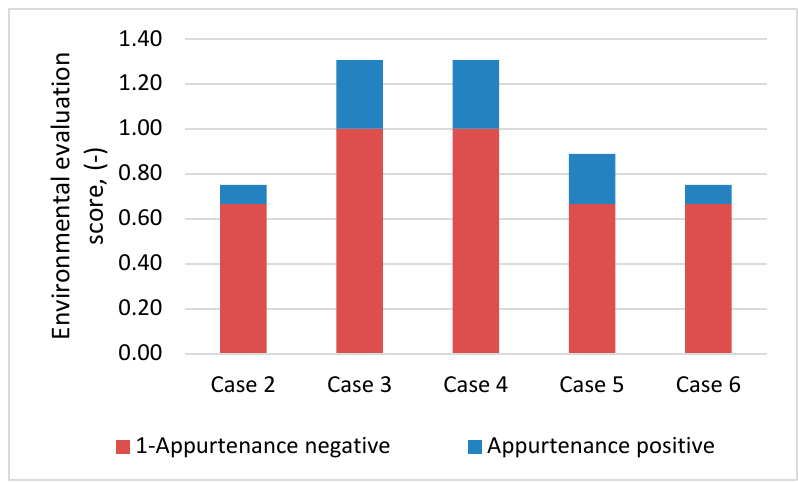
Figure 11. The overall evaluation of the cases studied according to the environmental criteria.